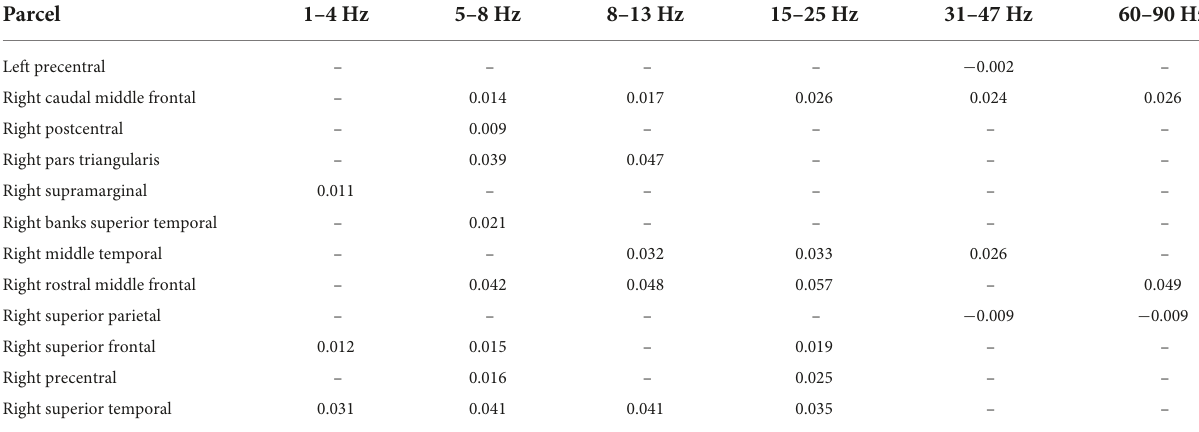
TABLE 2 Group-level mean differences in power reduction by SOBI-FastICA and AMICA for parcel-frequency band combinations containing points with systematic group-level differences (cf. Figure 6 ).